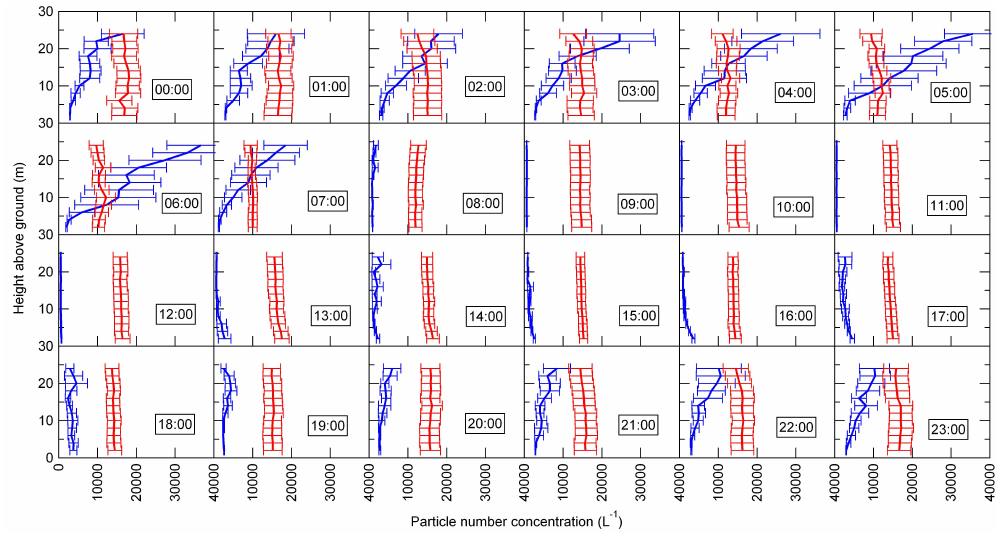
Fig. 5. Diurnally averaged hourly profiles of aerosol number concentration within the canopy and trunk space. These are separated into sub- micron (0.3–1µm; red lines) and supermicron (1–20µm; blue lines) within the range of the GRIMM aerosol spectrometer. Local (GMT+8) start time of each hourly period is shown. Error bars represent one standard